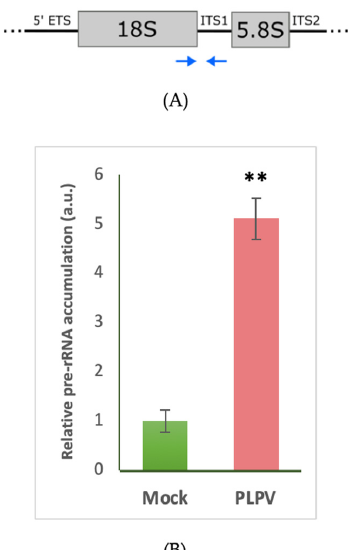
Figure 3. Relative accumulation of pre-rRNA. ( A ) Fragment of the rRNA unit. Blue arrows below depict the position of the primers used in the analysis. ( B ) RT-qPCR analysis of systemic leaves from mock-inoculated (green) and PLPV-infected (red) plants harvested at 34 d.p.i. Bars depict standard deviations from three independent biological replicates and the statistical significance was tested using a paired t -test (** p <